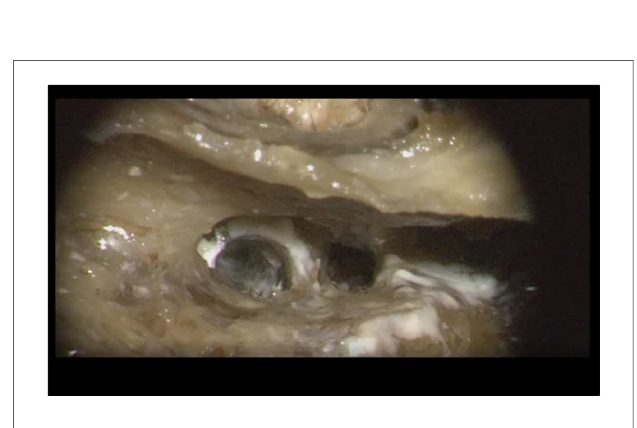
FIGURE 2 Posterior tympanotomy with cochleostomy and second turn access in the left temporal